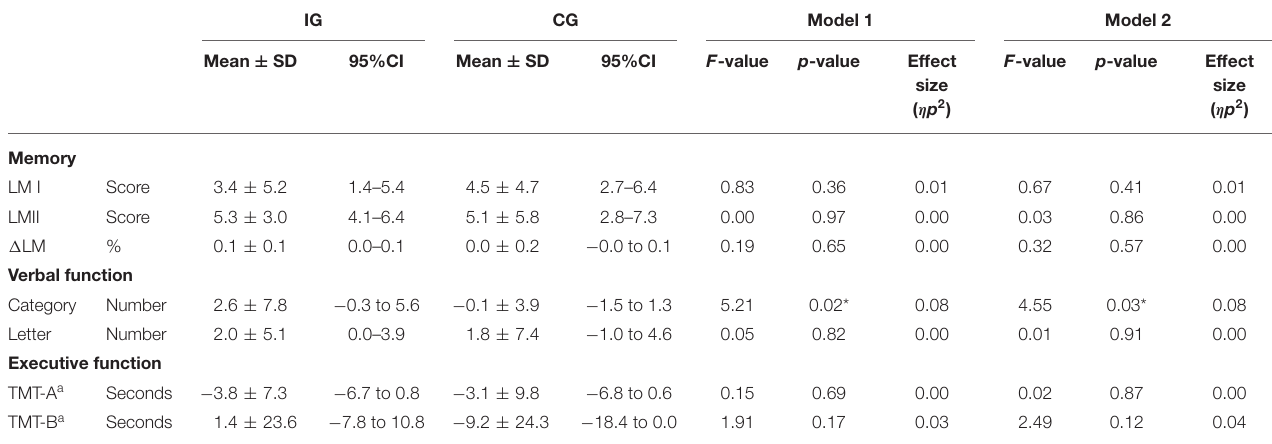
TABLE 3 | Cognitive test change scores of participants who completed the pre-test and